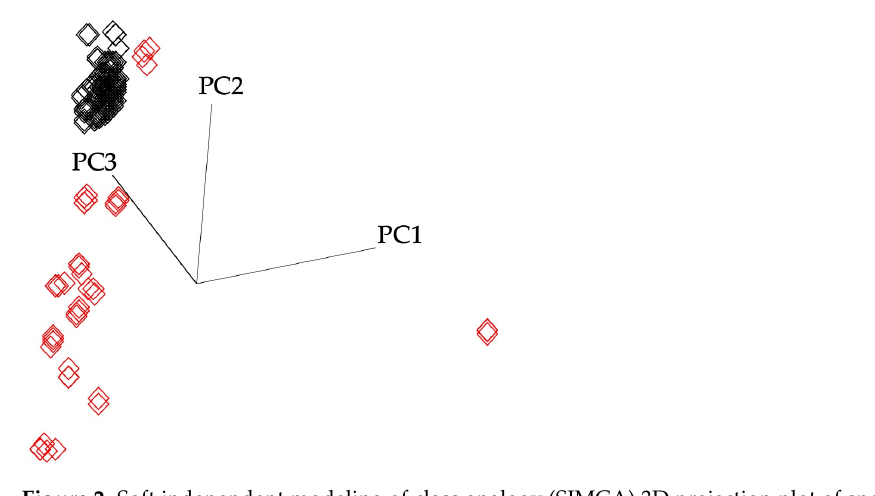
Figure 2. Soft independent modeling of class analogy (SIMCA) 3D projection plot of spectral data for honey samples collected by portable FT-IR sensor. The red squares show suspicious honey samples, whereas the black ones indicate the pure honey samples.